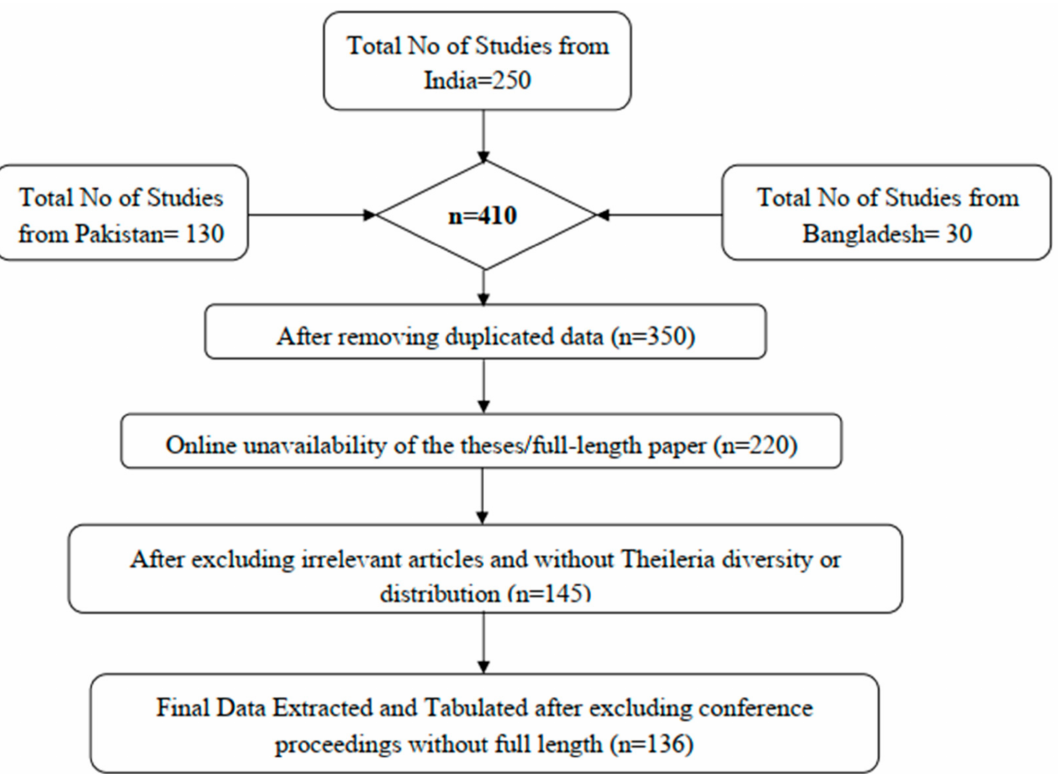
Figure 3. Flow chart diagram showing the data retrieving and extraction procedure.